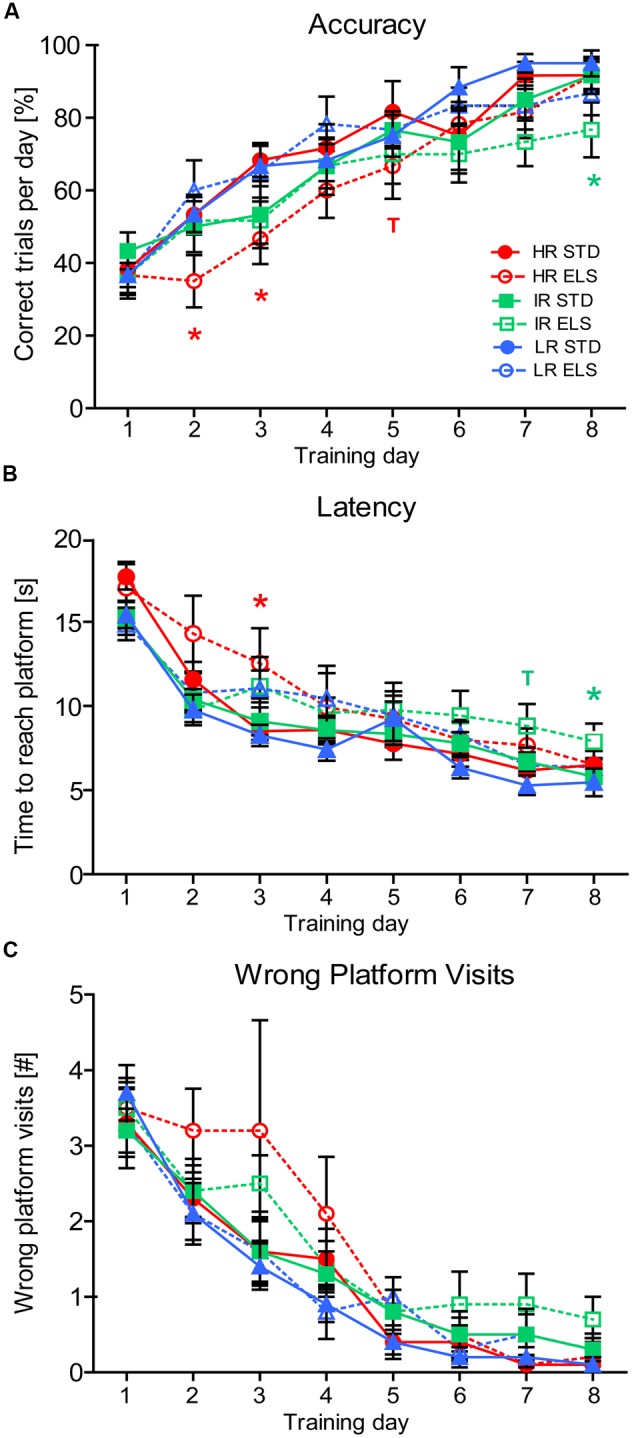
Water Cross-Maze test. Test performance of HR, IR, and LR mice, raised in ELS or STD housing conditions was analyzed by univariate ANOVA, N = 10 per group. Data was analyzed using repeated-measures ANOVA and is presented as line plots showing means and SEM (error bars). (A) The accuracy of the animals task performance showed a within-subjects main effect of training day (F7,378 = 62.794, p < 0.001), and a trend for a between-subjects main effect of condition (F1,54 = 2.882, p = 0.095), but no effect of line (F2,54 = 1.753, p = 0.183). Specifically, HR ELS mice were less accurate than HR STD mice on testing days 2, 3, and 5 (p = 0.040, p = 0.032, p = 0.094) and IR ELS mice were less accurate than IR STD mice on day 8 (p = 0.048). Overall pairwise comparisons showed a trend for poorer accuracy in the HR ELS compared to HR STD animals (F1,54 = 3.085, p = 0.085), but no difference in the IR and LR lines(F1,54 = 0.986, p = 0.325, and F1,54 = 0.036, p = 0.849). (B) The latency to reach the hidden platform showed a within-subjects main effect of training day (F7,378 = 85.502, p < 0.001), and a between-subjects main effect of condition (F1,54 = 4.123, p = 0.047), but no effect of line (F2,54 = 0.635, p = 0.534). Specifically, HR ELS mice had a higher latency than HR STD mice on testing day 3 (p = 0.032) and IR ELS had a higher latency than IR STD mice on days 7 and 8 (p = 0.060 and p = 0.040). Overall pairwise comparisons were not significant (HR: F1,54 = 1.562, p = 0.217, IR: F1,54 = 1.218, p = 0.275, LR: F1,54 = 1.353, p = 0.250). (C) The number of wrong platform visits showed a within-subjects main effect of training day (F7,378 = 60.502, p < 0.001), and a trend for a between-subjects main effect of condition (F1,54 = 3.376, p = 0.072), but no effect of line (F2,54 = 1.348, p = 0.268). No particular day showed significant differences between conditions, but overall pairwise comparisons revealed a trend for an increased number of wrong platform visits in the HR ELS compared to HR STD mice (F1,54 = 2.891, p = 0.095), but not in IR and LR animals IR: F1,54 = 1.188, p = 0.281, LR: F1,54 = 0.154, p = 0.696). ∗∗∗p ≤ 0.001, ∗∗p ≤ 0.01, ∗p ≤ 0.05; Tp ≤ 0.1. Post hoc statistics for main effects of condition and the interaction are presented above the appropriate data points of the line plot in the corresponding color.